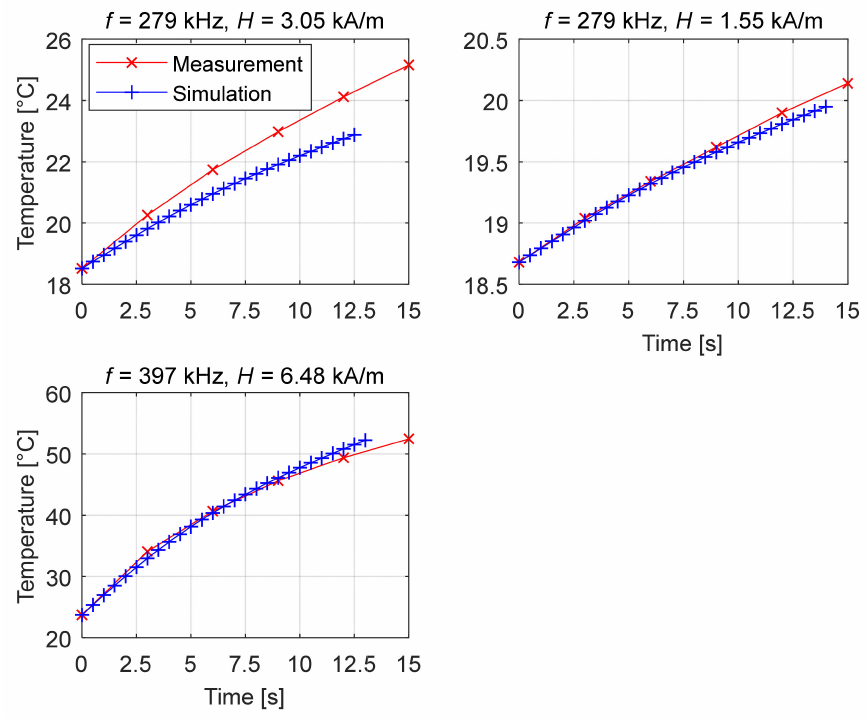
Figure 15. Comparison of time–temperature of measurement and simulation at the selected point.